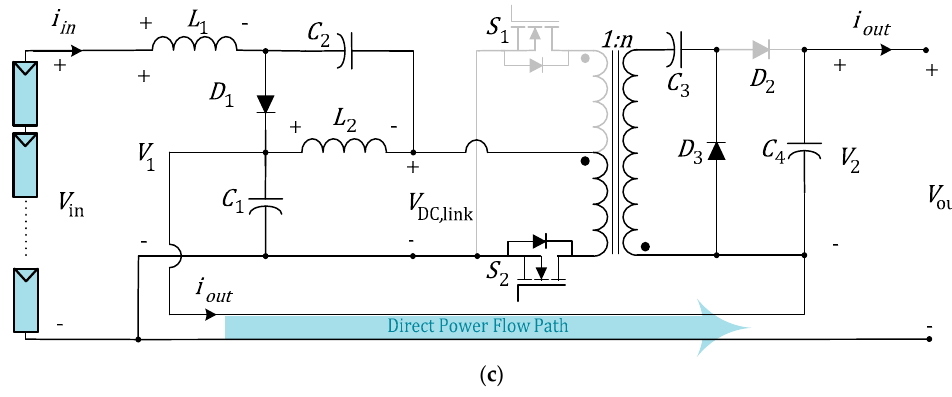
Figure 4. Operation modes of the proposed PPP QZSC: ( a ) Shoot-through mode, ( b ) Non-shoot-through and S 1 is ON, S 2 is off, ( c ) Non-shoot-through and S 2 is ON, S 1 is off.